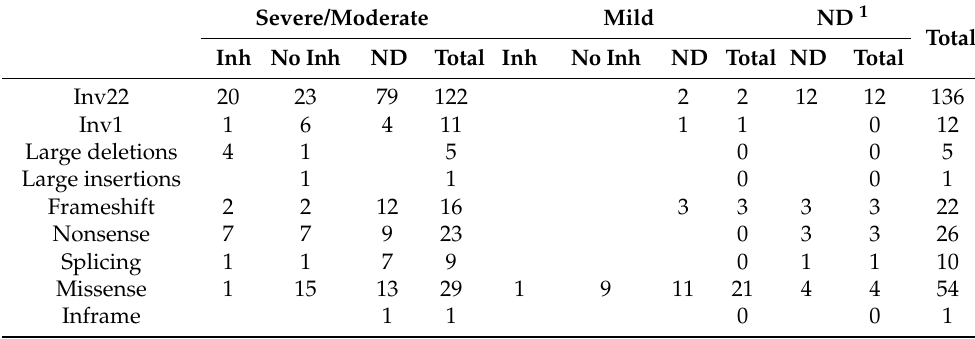
Table 1. Summary of severity and inhibitor data in patients from this study.